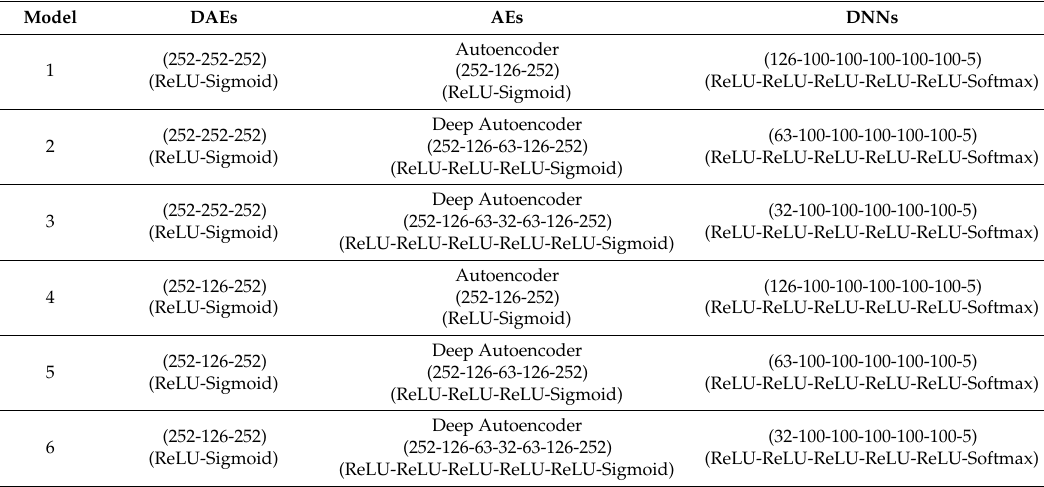
Table 2. Model validation of ECG heartbeat classification.